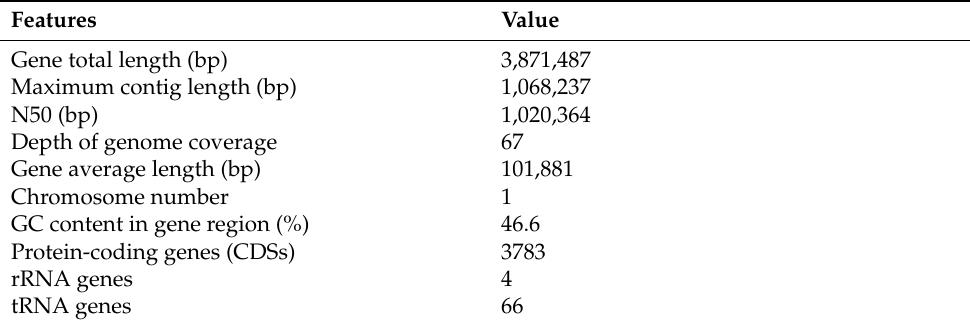
Table 4. Genomic features of Bacillus velezensis IALR619.